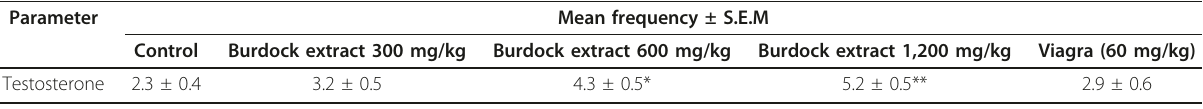
Table 2 Effect of administration of aqueous extract of burdock roots for 15 days on serum testosterone concentrations